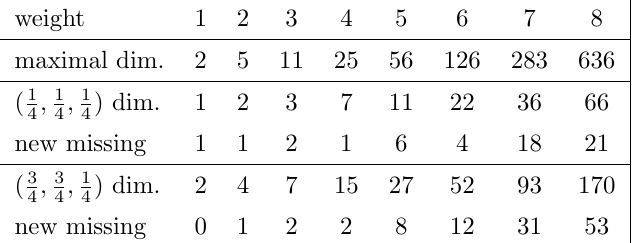
Table 21 . Dimensions of H hex when restricted to the 6 th root of unity points ( 1 for weights up to